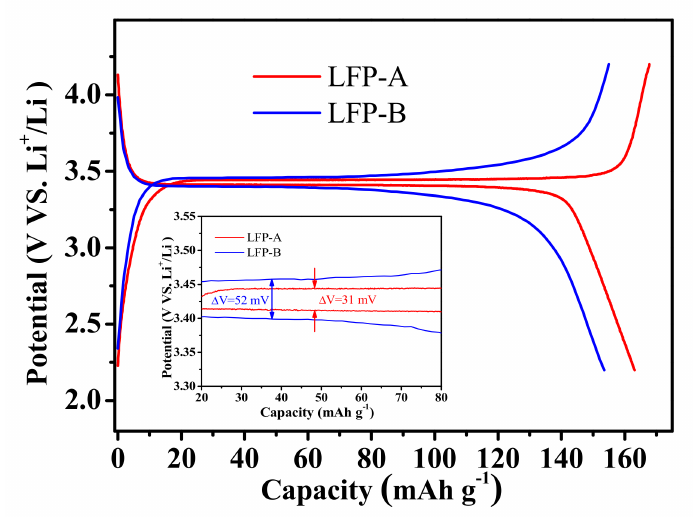
Figure 5. Charge/discharge profiles of the two samples at 0.1 C rate. The inset shows the magnified flat region.